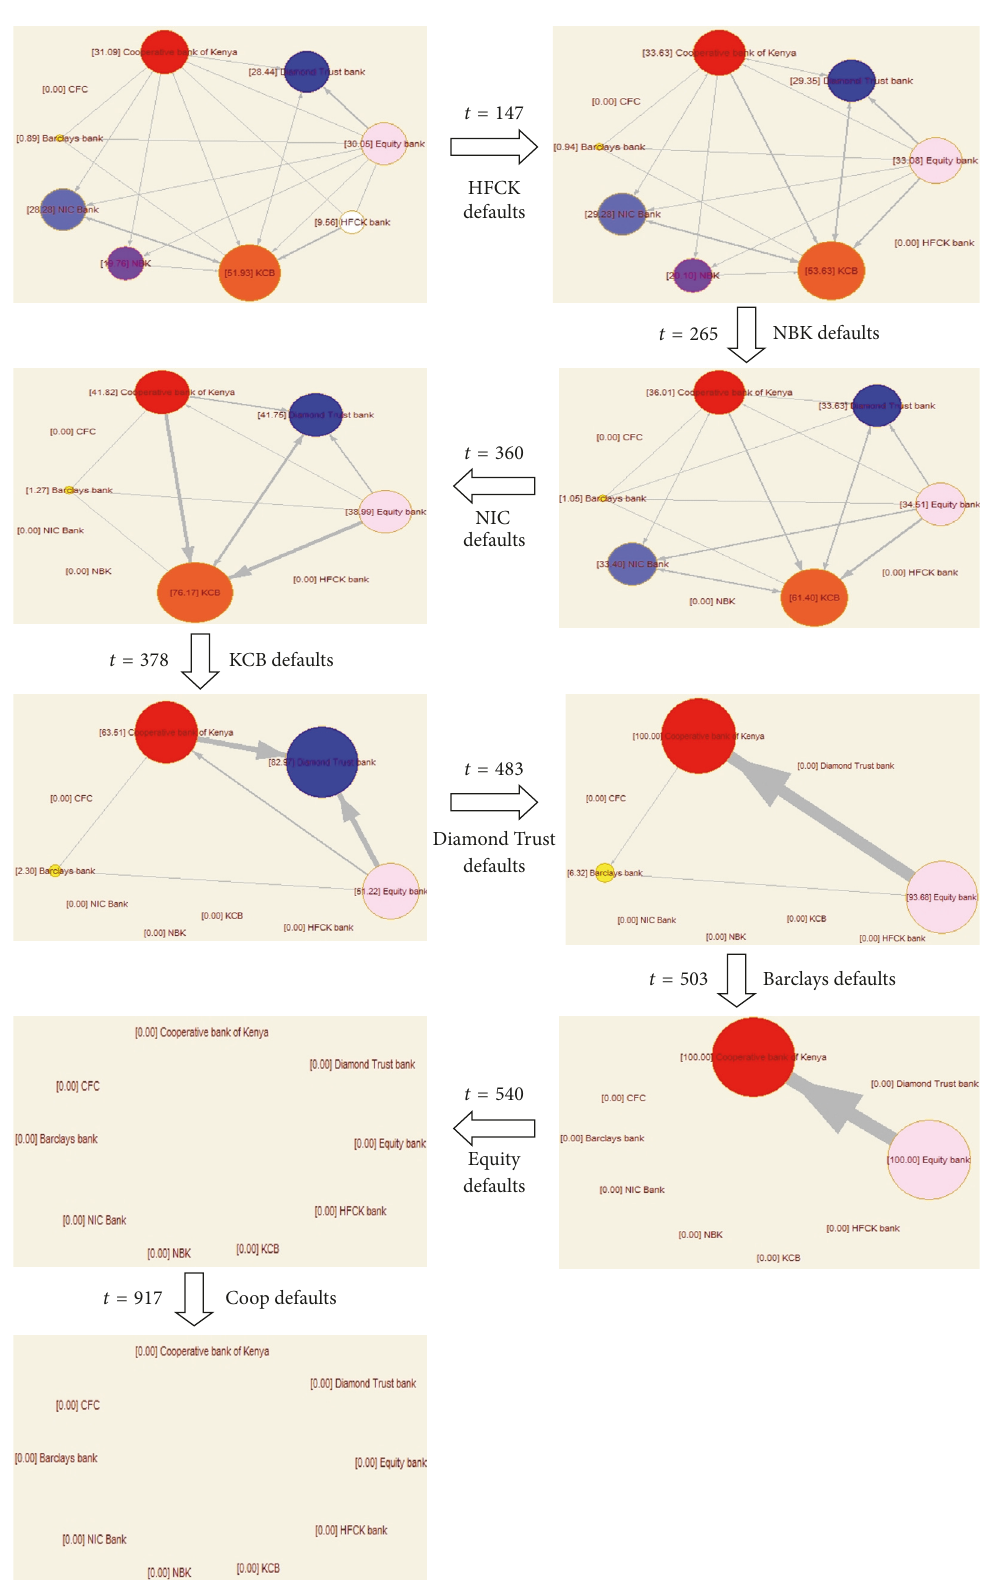
Figure 6: The evolution of the network topology in 2015 estimated by the minimum density approach with parameter 𝑐 = 10